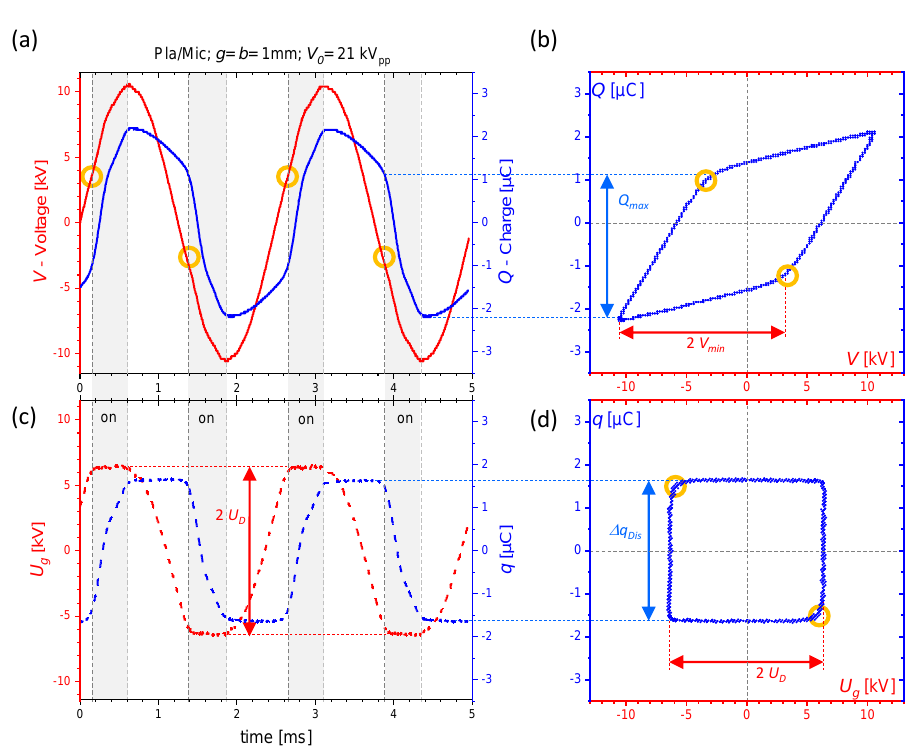
Figure 2. ( a ) Typical voltage V ( t ) and charge Q ( t ) signals measured for a plane-parallel volume DBD of Figure 1 in CO 2 . These signals result in the parallelogram-shaped Q-V plot ( b ). The orange circles show the time when the plasma ignites in each half period. Processing V ( t ) and Q ( t ) by Equations (8) and (7) result in the slopes of the gap voltage and the charge transferred into the plasma U g ( t ) and q ( t ) as shown in ( c ). These signals form the “quadratic” q - U g plot in ( d ). The enclosed areas of both Q-V plots are identical and give the energy per period W = P / f (about 40mJ in this example).